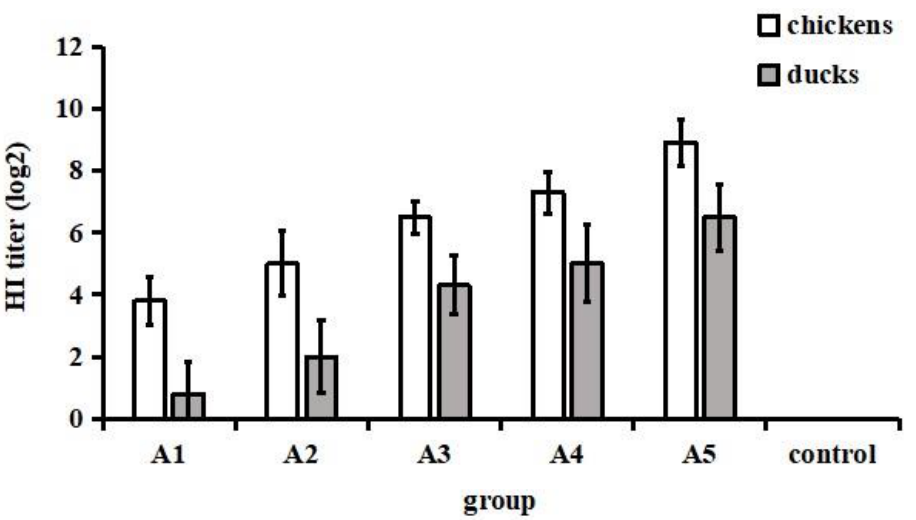
Figure 2. HI antibody titres in chickens and ducks immunized with different volumes of inactivated vaccine. Twenty-eight-day-old SPF chickens and ducks were given the developed inactivated vaccine subcutaneously. At three weeks after immunization, sera were collected for HI antibody determination by the haemagglutination inhibition (HI) test.